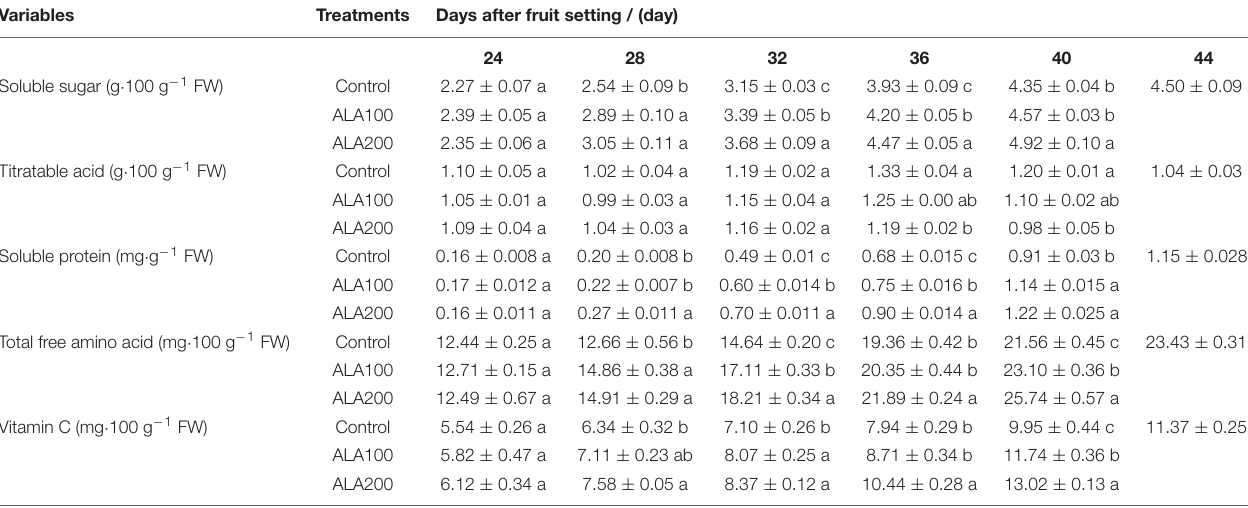
TABLE 2 | Effects of ALA on the soluble sugar, titratable acid, soluble protein, total free amino acid, and vitamin C contents of tomato fruits. Variables Treatments